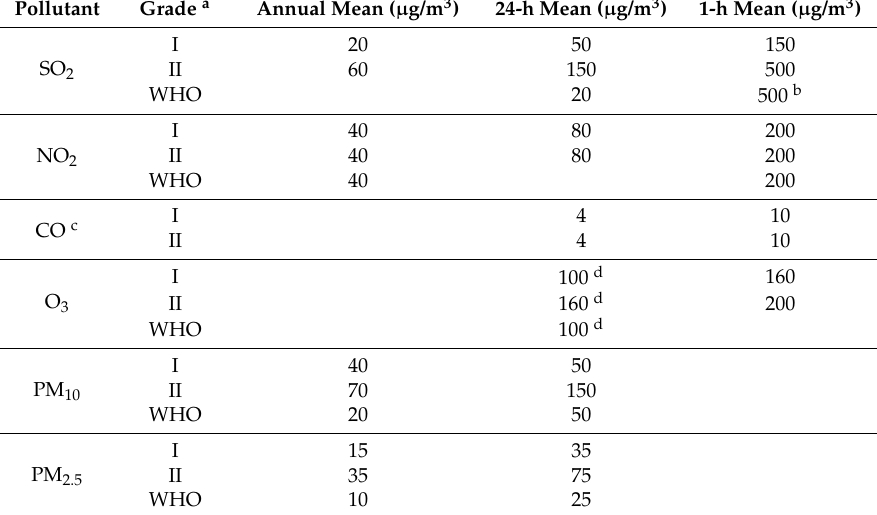
Table 1. Chinese air quality standards for concentrations of SO 2 , NO 2 , CO, O 3 , PM 10 , and PM 2.5 [10]. Also shown for comparison are the World Health Organization (WHO) air quality guidelines, where they exist